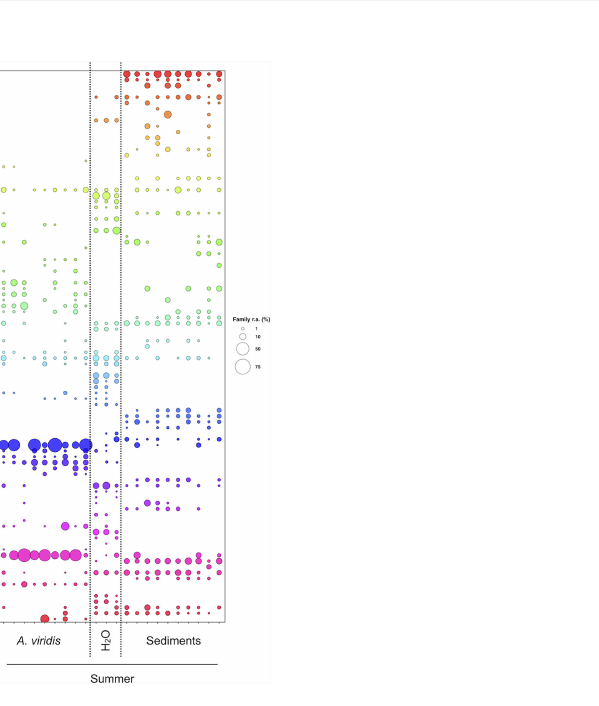
FIGURE 4 Metacommunity bubble plot at family level in the Riccione site. Bubble plot of the compositional structure of winter and summer A. viridis microbiota samples compared with the surrounding ecosystems (seawater and sediments) at the Riccione site. A. viridis microbiota components showing a differential distribution between winter and summer samples according to the MaAsLin2 model are indicated by red arrows. The size of the bubbles represents the percentage of relative abundance according to the legend on the